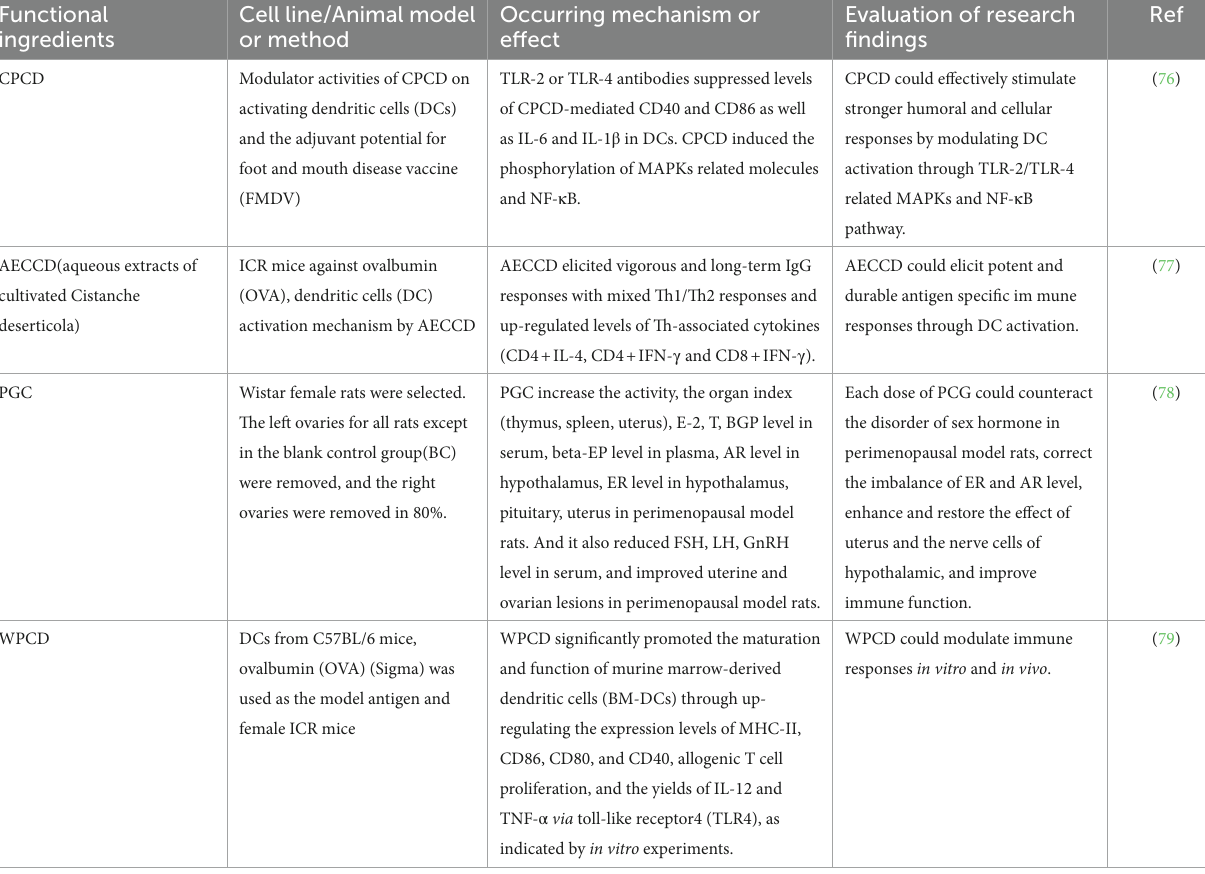
TABLE 7 Immunomodulatory mechanism of cistanche. Functional ingredients